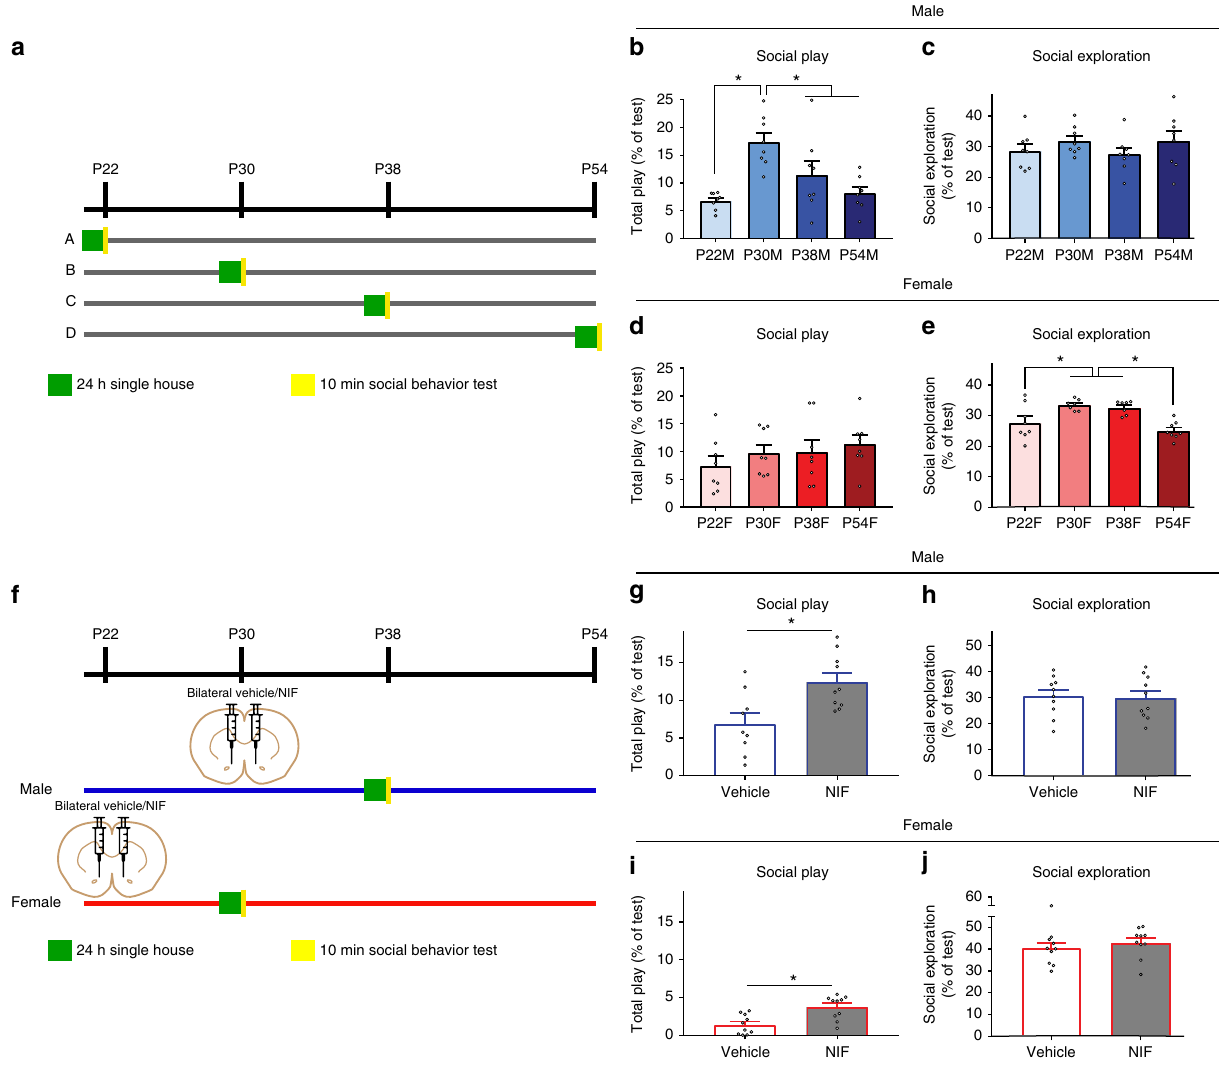
Fig. 4 Sex-speci fi c social behavior patterns over adolescence require C3 – C3R interactions. a Experimental design: separate cohorts of experimental animals ( n = 8/sex/age) were single-housed for 24 h prior to test, after which time a novel age-matched and sex-matched conspeci fi c was introduced into their home cage. Ten minutes of interactions were recorded, and later an experimenter blinded to the conditions coded the interactions for either total play or social exploration (i.e., non-play social behavior). Only behaviors initiated by the experimental animal were considered. Males: b Male social play behavior transiently increased at P30 (Table 4A), c with no changes in social exploration over development (Table 4B). Females: d Female social play behavior did not change over development (Table 4C), e while social exploration peaked from P30 to 38 (Table 4D). f To determine if C3 – C3R interactions regulating D1r levels between P30 and 38 in males is required for the decline in social play behavior observed at this time, NIF or vehicle was injected bilaterally in P30 males or P22 females ( n = 10/sex/treatment). Animals were then single housed for 24 h at P37 or P29, and assessed for social behavior as described at P38 and P30, respectively. Males: g Interrupting C3 – C3R interactions at P30 increased social play behavior at P38 (Table 4E), h without affecting social exploration (Table 4F). Females: i Female social play behavior, while at a low basal level, also modestly increased at P30 after P22 NIF injection (Table 4G), j with no changes in social exploration (Table 4H). Data were analyzed either with one-way ANOVAs and Holm-Sidak ’ s post-hoc comparisons or with two- tailed unpaired t -tests. Histograms portray the mean ± SEM with individual data points overlaid. Signi fi cant post-hoc Holm-Sidak t -tests ( b – e ) and unpaired t -tests ( g – j ) ( p < 0.05) comparisons are delineated with an asterisk. All statistics are in Table